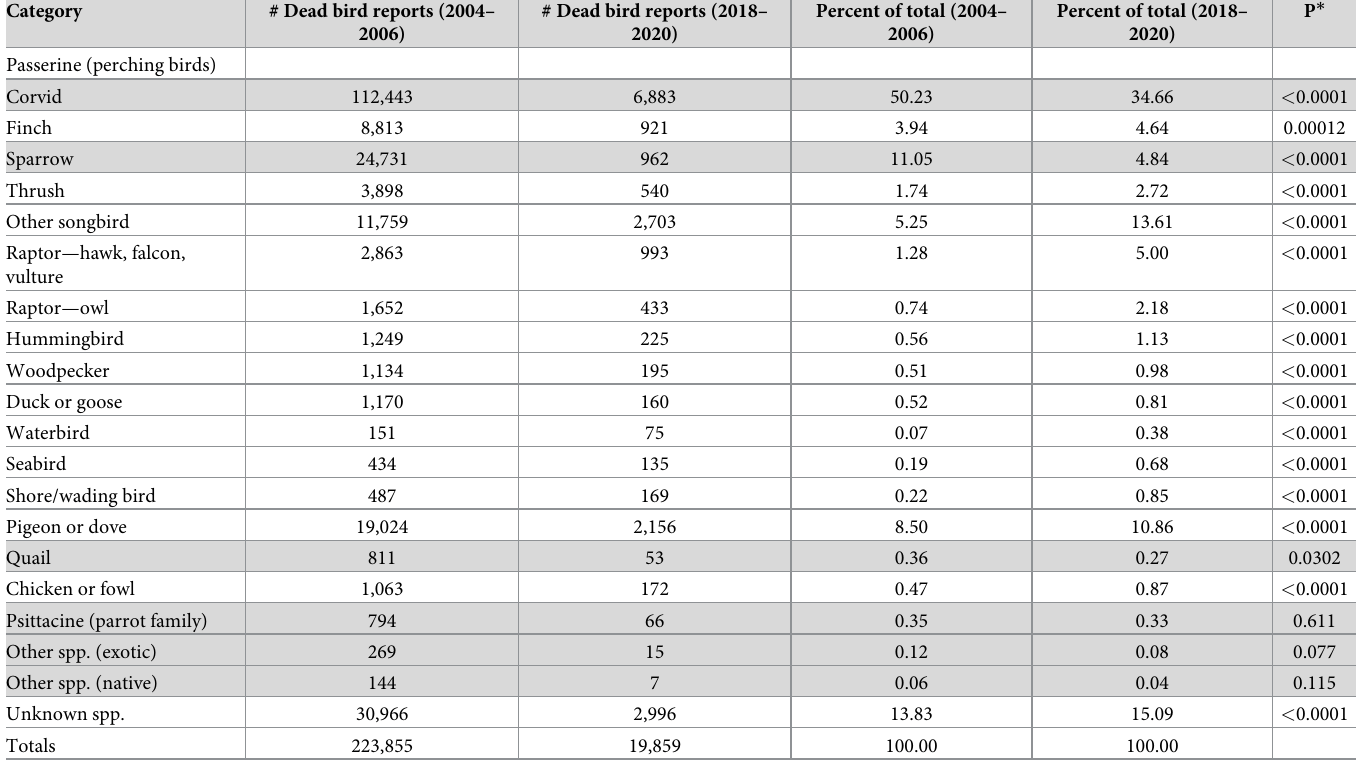
Table 2. Dead bird report totals by category and percentages of total reported birds, early versus later years. Unshaded categories increased in proportion while shaded species decreased. Category # Dead bird reports (2004– 2006)